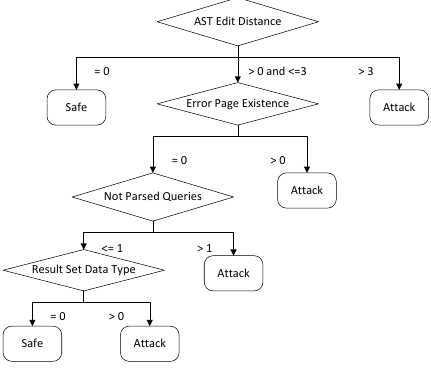
Figure 4. The Learned Decision Tree